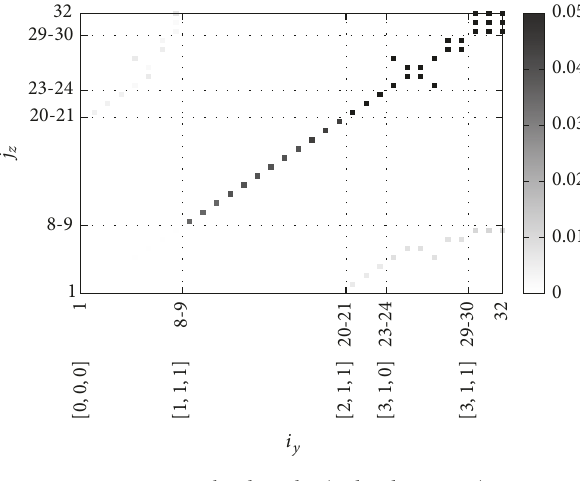
Figure 6: Cuboid modes (3rd order, 𝑁 = 1 ).